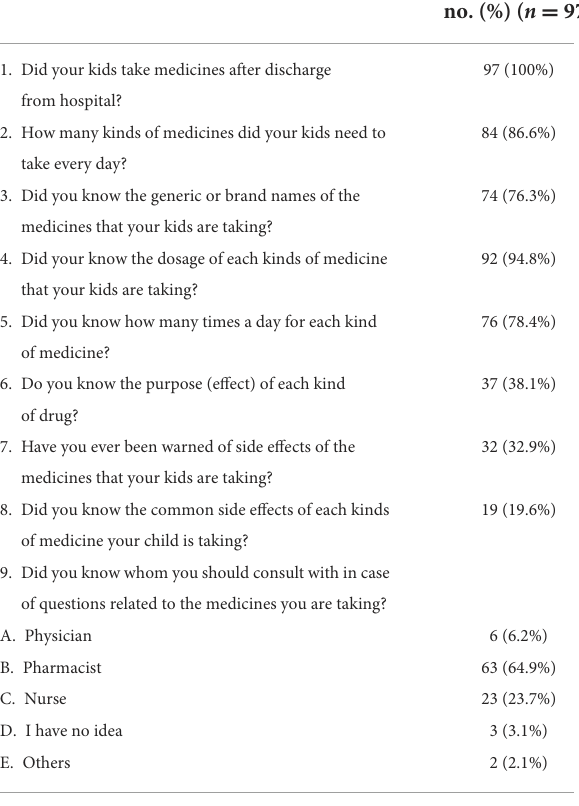
TABLE 2 Medication literacy for caregivers of discharged children with KD.